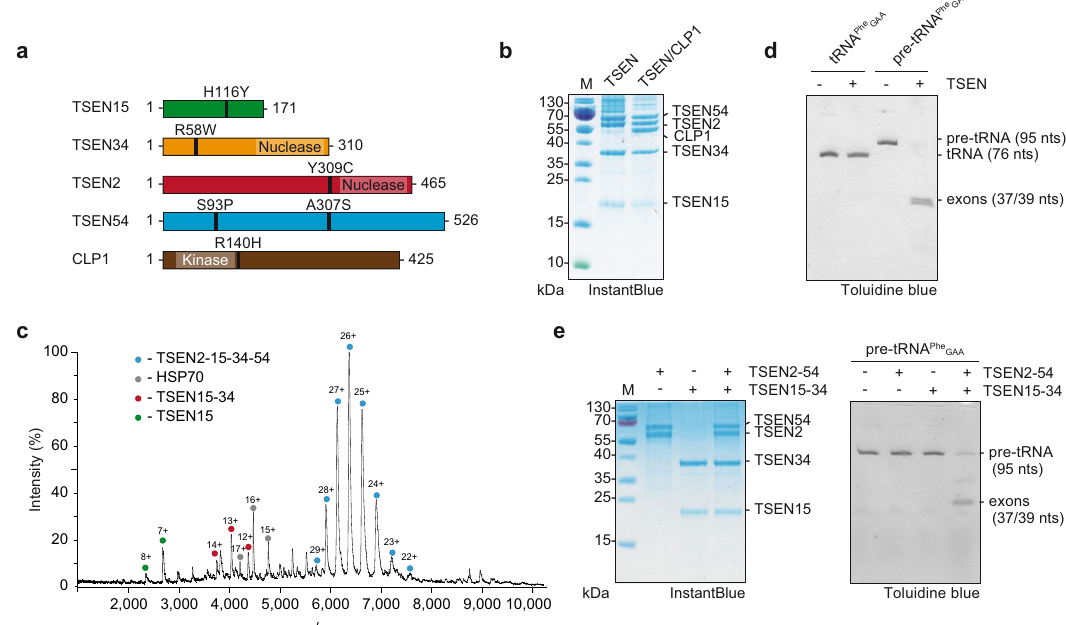
Fig. 1 Assembly and catalysis of recombinant human TSEN. a Bar diagrams of TSEN subunits (TSEN15, green; TSEN34, orange; TSEN2, red; TSEN54, blue) and CLP1 (brown) depicting positions of PCH mutations, predicted nuclease domains of TSEN2 and TSEN34, and the RNA kinase domain of CLP1. The total amino acids of each protein are indicated. b SDS-PAGE of puri fi ed recombinant TSEN and TSEN/CLP1 complexes visualized by InstantBlue staining. Protein identities and size markers are shown. c Native mass spectrum of tetrameric TSEN complex from an aqueous ammonium acetate solution. Charge states of the predominant TSEN2 – 15 – 34 – 54 heterotetramer (blue circles), Heat Shock Protein (HSP) 70 (gray circles), the heterodimer TSEN15 – 34 (red circles), and TSEN15 (green circles) are indicated. d Pre-tRNA cleavage assay using tetrameric TSEN complex with Saccharomyces cerevisia e ( S.c .) pre- tRNA Phe GAA and mature tRNA Phe GAA . Input samples and cleavage products were separated via urea-PAGE and visualized by Toluidine blue. RNA denominations are given on the right. e Pre-tRNA cleavage assay with TSEN heterodimers and S.c . pre-tRNA Phe GAA . SDS-PAGE of the indicated heterodimers and the reconstituted TSEN tetramer is shown on the left (InstantBlue stain), urea-PAGE of the cleavage products on the right (Toluidine blue stain). Gels are representative of three independent experiments. Source data for b , d , and e , are provided as Source Data fi